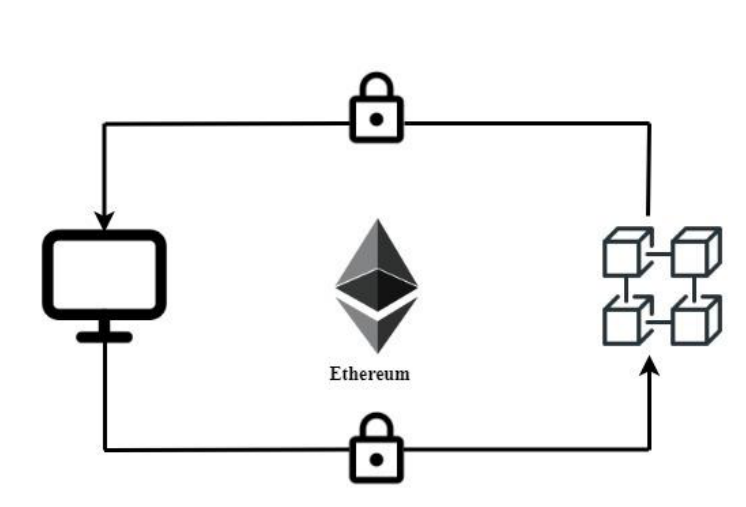
Figure 4. Ethereum transaction structure.